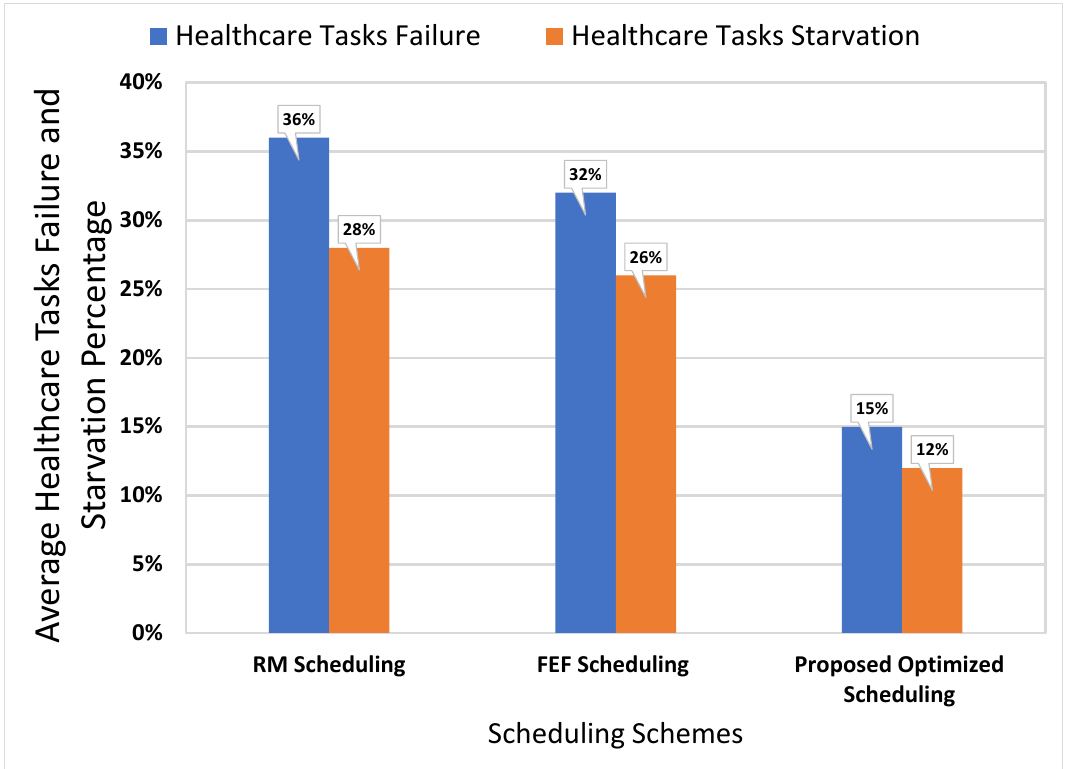
Figure 11. Performance analysis of event and periodic healthcare tasks in terms of Response